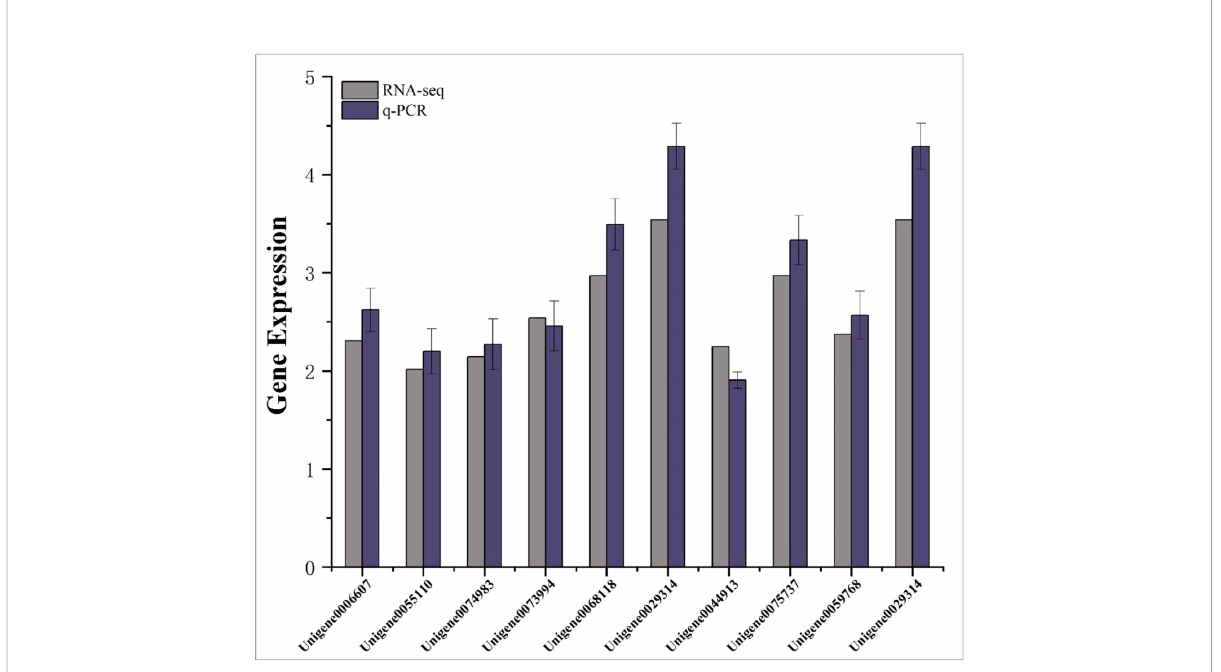
FIGURE 9 Transcriptome RPKM values and q-PCR relative expression values of differentially expressed genes. The abscissa represents the gene name; the ordinate represents the gene expression